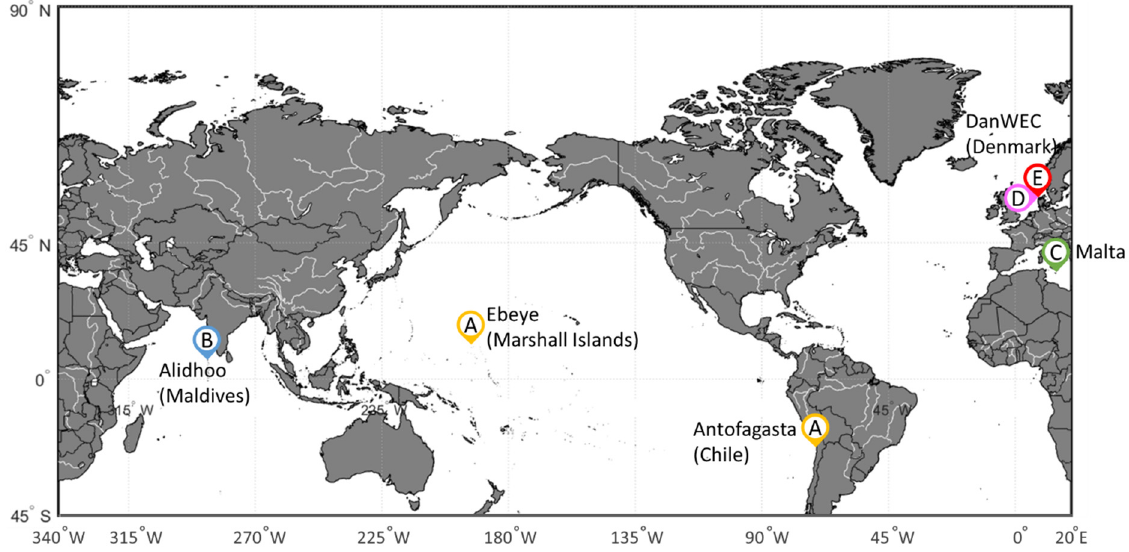
Figure 5. Sites’ location and class with reference to Table 3.